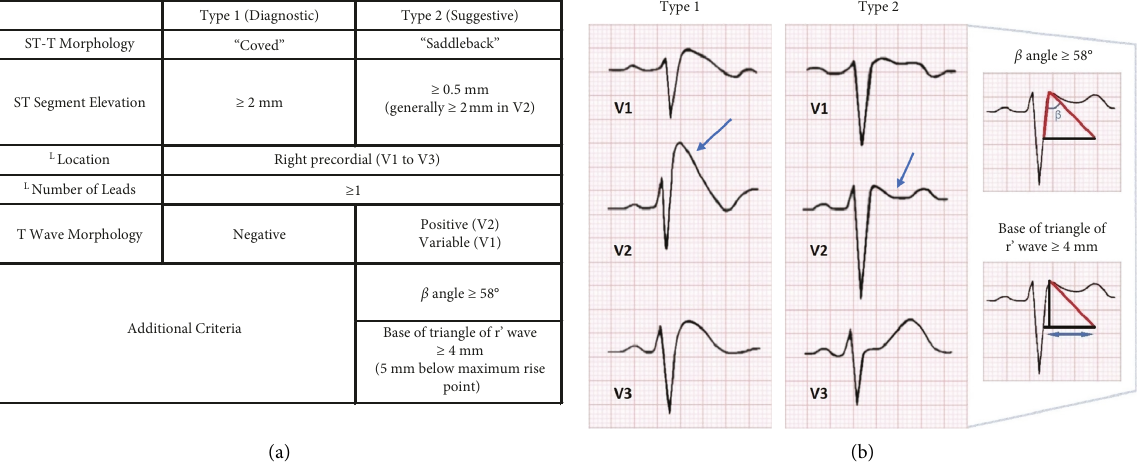
Figure 2: (a) Distinguishing characteristics of the two types of Brugada syndrome patterns. (b) Example ECG tracings of the two types of Brugada syndrome patterns, demonstrating the “coved” and “saddleback” ST-T morphology of type I and type II, respectively.